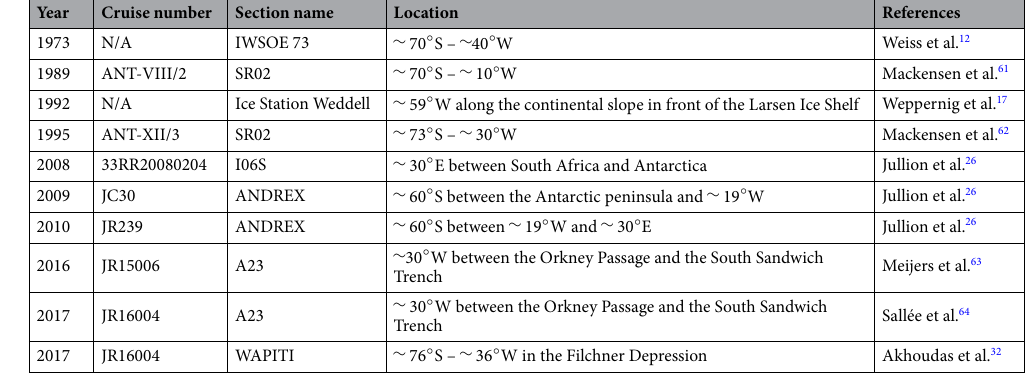
Table 1. Summary of the cruise datasets used in this study. N/A information not